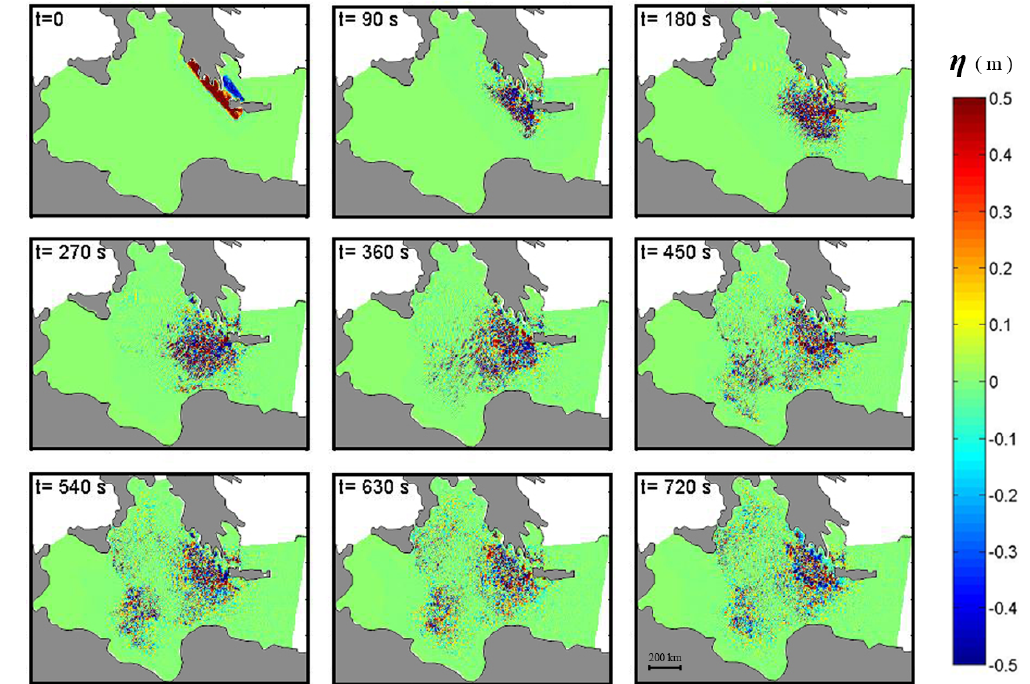
Figure 5. Snapshots of the free surface ( η ) hydro-acoustic perturbation given by the AD 365 Crete earthquake. t = 0 refers to the time of occurrence of the earthquake.